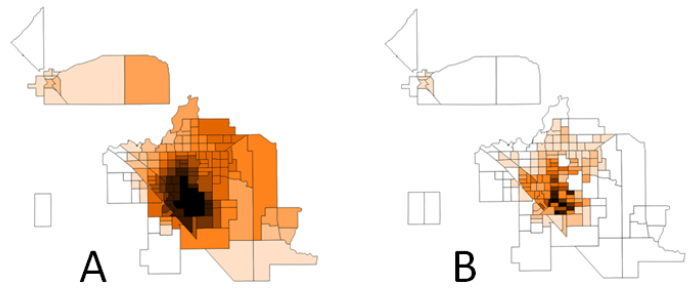
Figure 4. Fresno UHII as the difference from reference points. Lightest color is 2 DH/day; darkest color is 45 DH/day (°C.hr/day). ( A ): UHII; ( B ) UHII weighted by population density. Fresno is an